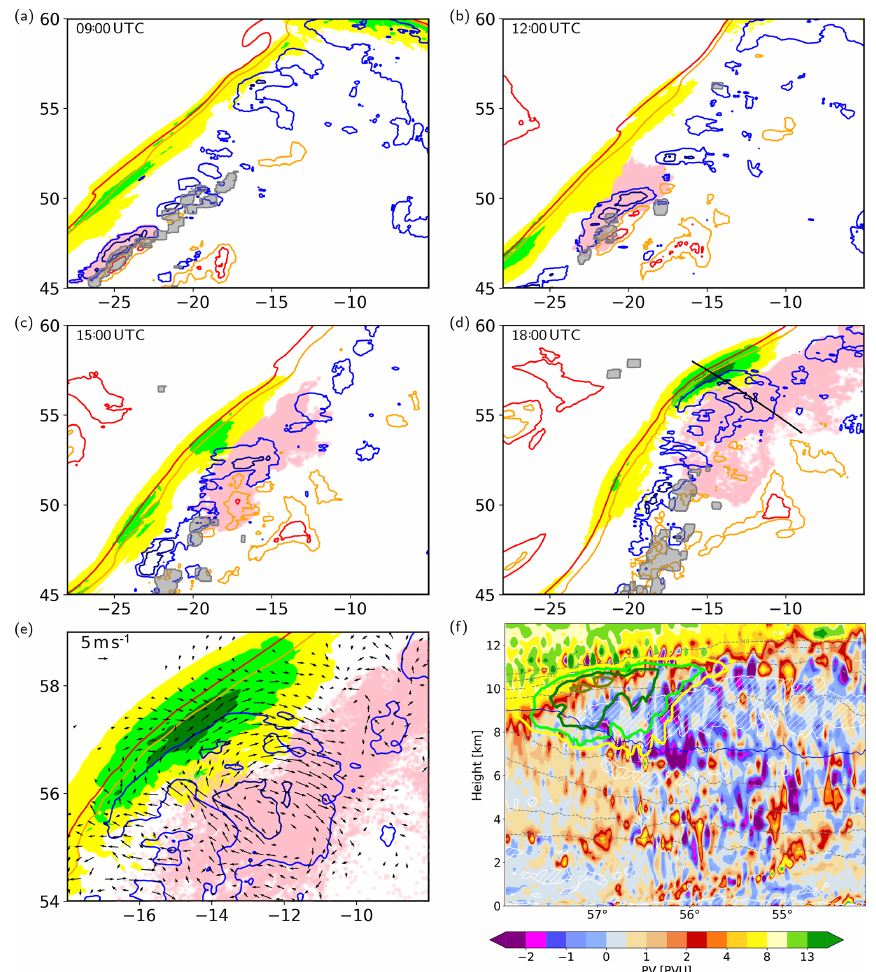
Figure 11. Spatially averaged upper-level PV at 320K (dark blue, blue, orange and red contours at − 1, 0, 1, and 2PVU), upper-level jet at 320K (yellow and green colors at 55, 60, and 65ms − 1 ), and envelope of rapid WCB ascent (grey contour and shading) at (a) 09:00UTC, (b) 12:00UTC, (c) 15:00UTC, and (d) 18:00UTC, 23 September 2016. The pink shading shows the positions of forward trajectories initialized in a region of convectively produced negative PV between 315 and 325K at 09:00UTC. Panel (e) is an enlargement of (d) and additionally shows the 2h circulation anomaly (black arrows). Panel (f) is a vertical cross section along the line shown in (d) for PV (colors, in PVU), potential temperature (dashed grey lines, every 5K), 320K isentrope (blue line), and jet (yellow and green contours, at 55, 60, 65, and 70ms − 1 ). Low static stability layers (d θ/ d z ≤ 2Kkm − 1 ) are indicated by the white contour and